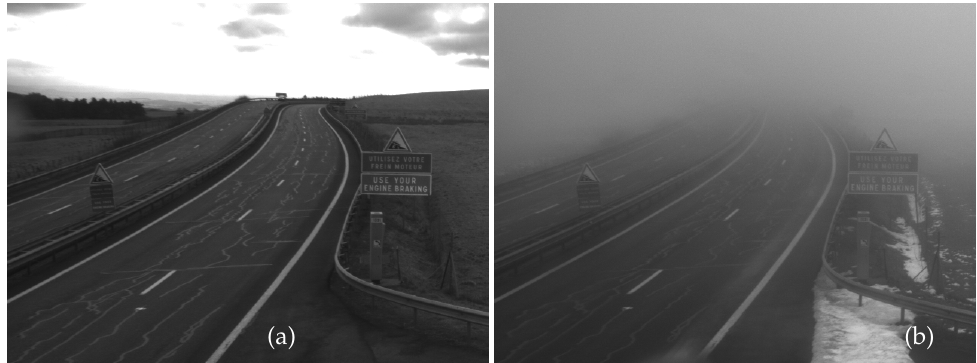
Figure 10. Real camera images taken from a section of the French A75 highway (at the Col de la Fageole point) without fog ( a ) and with fog (MOR = 156 m, ( b )), both images are in grayscale.